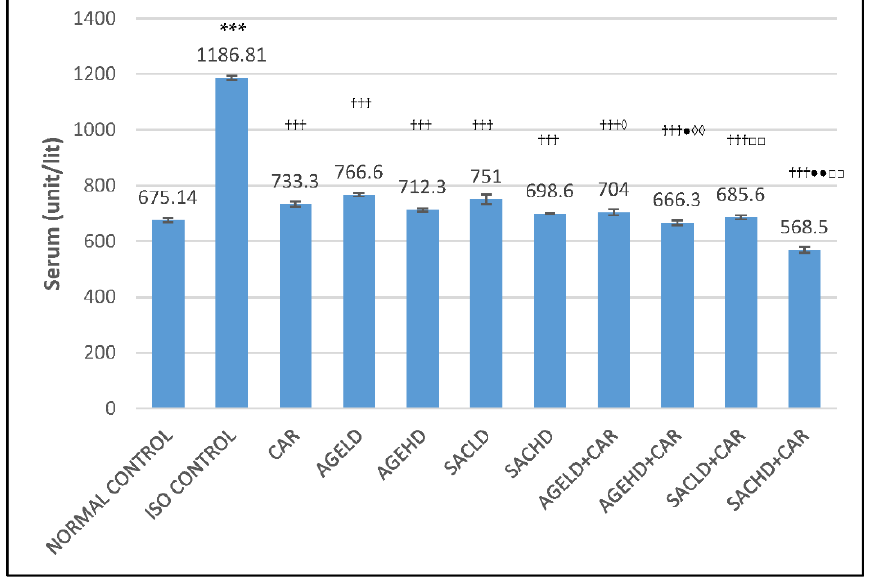
Figure 4. Effect on serum CK ‐ MB activities. The data are presented as mean ± SEM; *** p <0.001 compared with normal control; ††† p < 0.001 in comparison with ISO control; ● p < 0.05, ●● p < 0.01 in comparison with carvedilol; ◊ p < 0.05, ◊◊ p < 0.01 when compared with respective AGE dose; □□ p < 0.01 when compared with respective SAC dose.